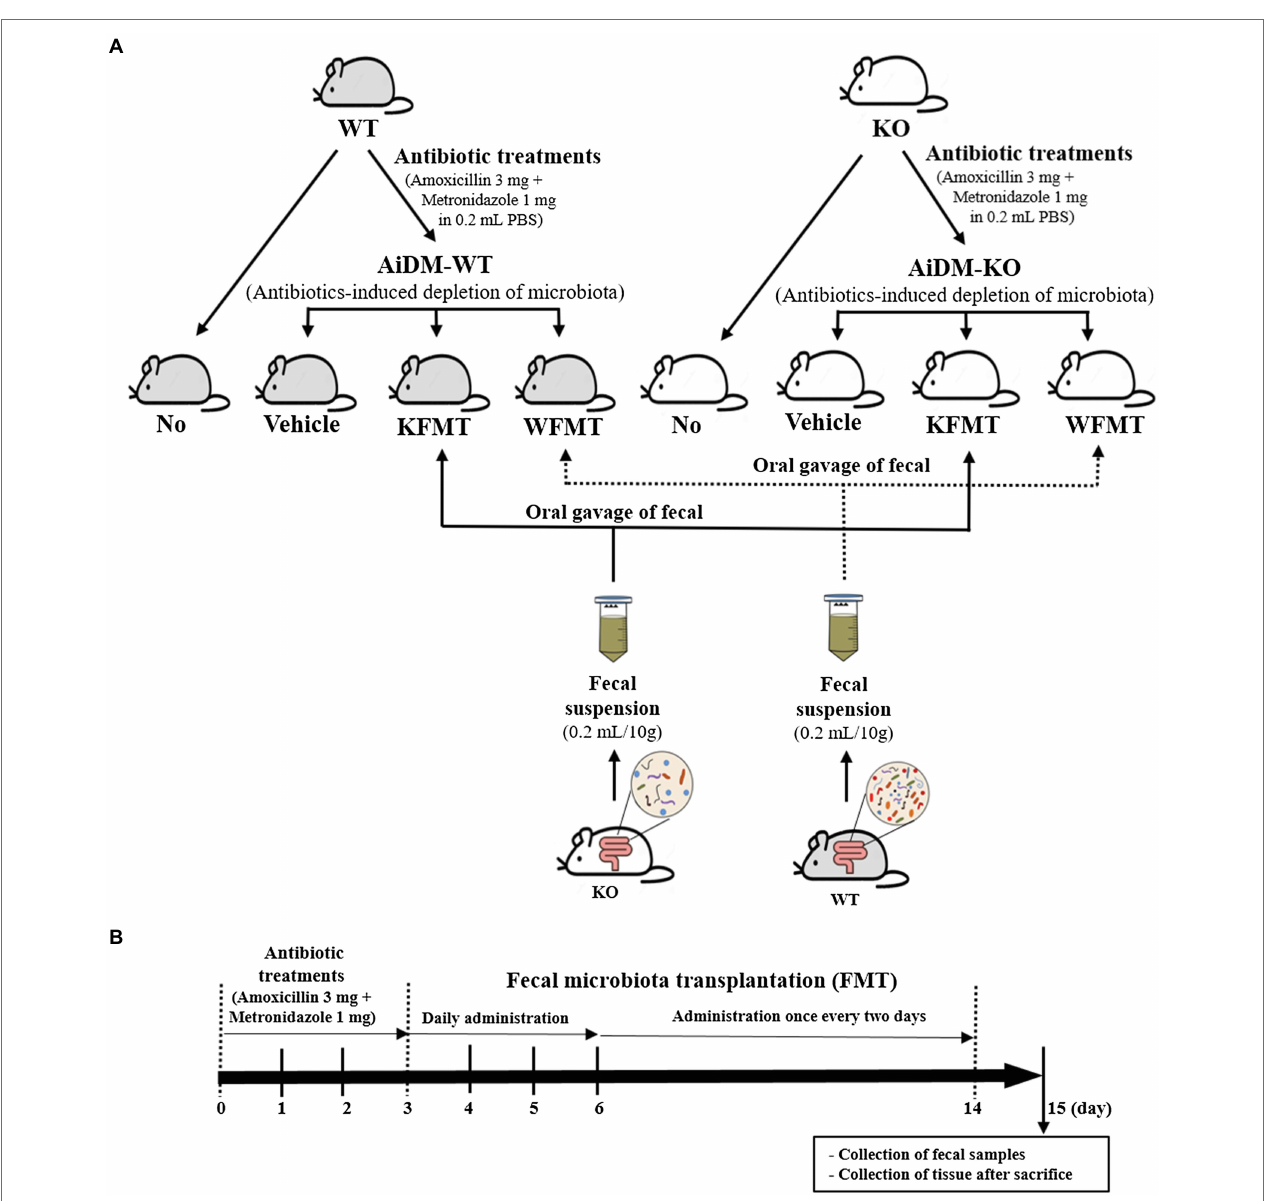
FIGURE 1 | Experimental scheme for fecal microbiota transplantation (FMT). (A) Treated groups. WT and KO mice were classified into four different groups: No, Vehicle, KFMT, and WFMT groups. (B) Treatment schedule. After antibiotics treatment for 3 days, AiDM models received fecal suspensions of WT or KO mice seven times over 2 weeks. WT, wild type; KO, knockout; FMT, fecal microbiota transplantation; KFMT, knockout mice FMT; WFMT, wild-type mice FMT; AiDM, antibiotics-induced depletion of microbiota; AiDM-WT, AiDM-wild-type mice; and AiDM-KO, AiDM-knockout